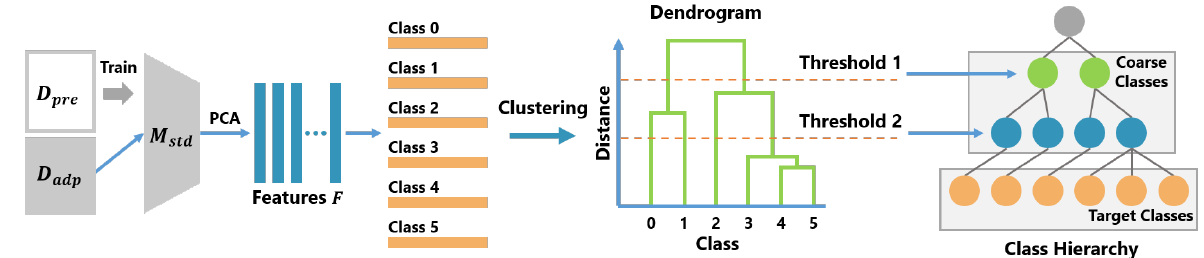
Figure 2. Overview of the class hierarchy construction